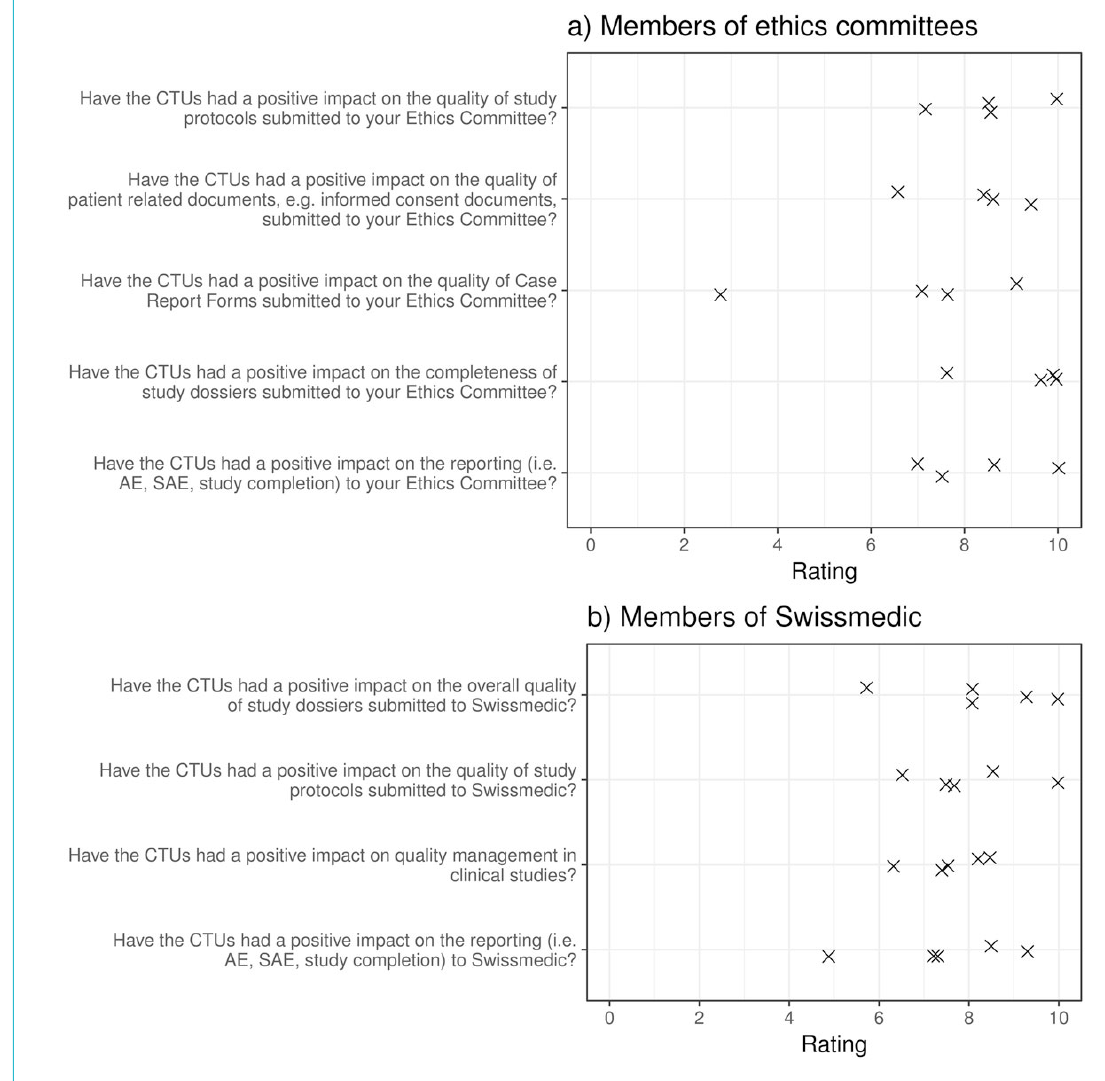
Figure 2: A stakeholder survey on the impact of CTUs on the quality of Swiss-based research: responses from ethics committees and from Swissmedic.A cross represents one answer of one member of (a) an ethics committee (a) or (b) Swissmedic, respectively, on a visual ana- logue scale from 0 to 10 (0: no impact at all; 10: maximum